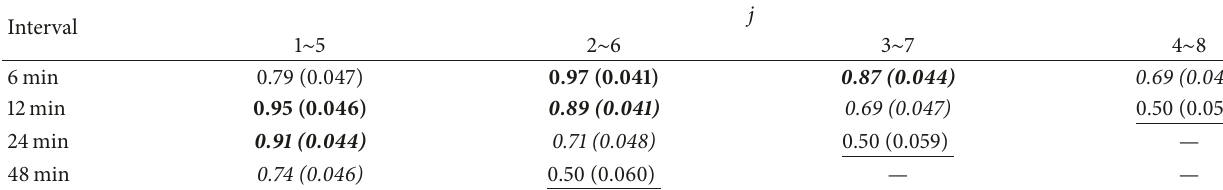
Table 6: Multiscales and multisampling for H of Site 3 (data length =